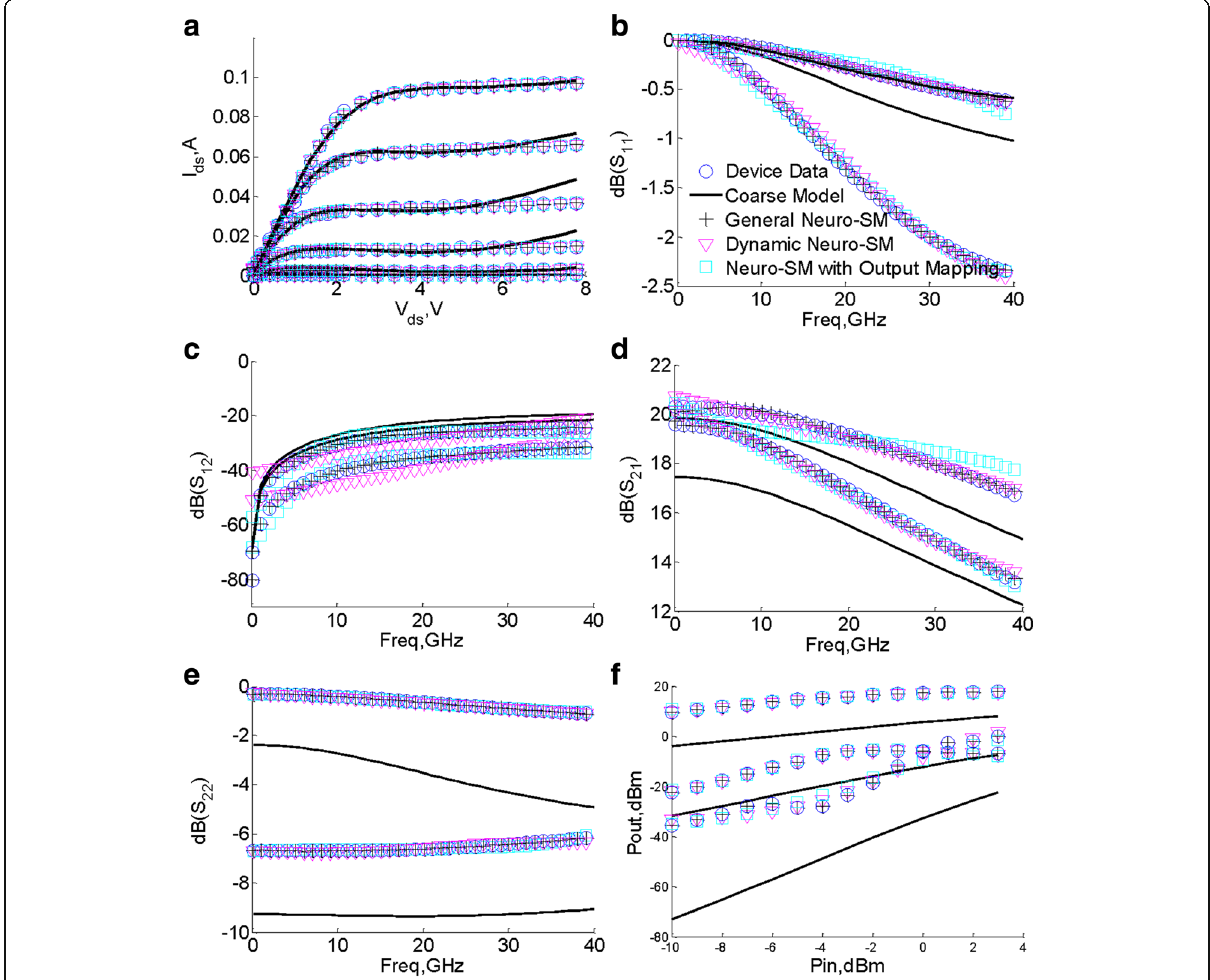
Fig. 3 Comparison between the pHEMT device data, coarse model, and three Neuro-SM models. a dc. b - e S parameter at two test biase points (0.7V, 2.4V) and (0.3 V 5.2V). f HB at different input power levels